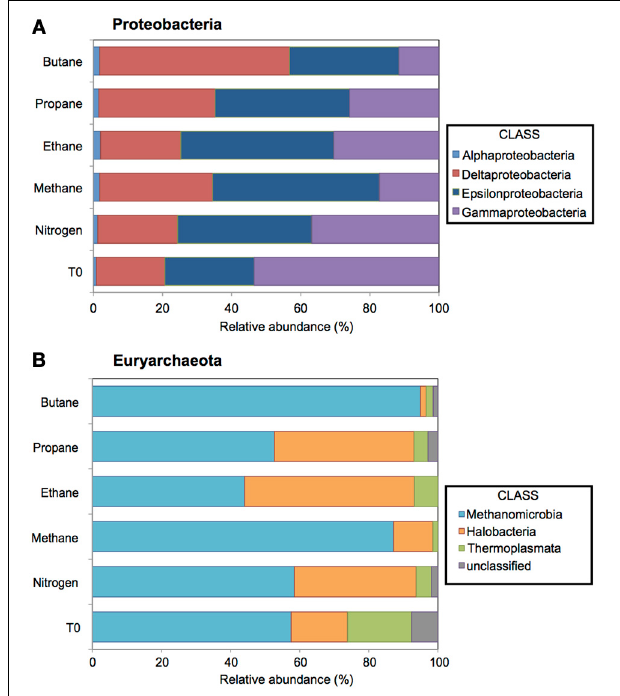
FIGURE 3 | Relative abundance (percentage) of Proteobacteria and Euryarchaeota determined from massively parallel pyrosequencing of DNA extracted from batch reactor sediments incubated with methane, ethane, propane, butane, and nitrogen and pre-incubation ( T 0 ) sediments. Top (A) and bottom (B) panels show the taxonomic breakdown of sequences at the class and order level, respectively. Sequences sharing 97% nucleotide sequence identity are defined as operational taxonomic units